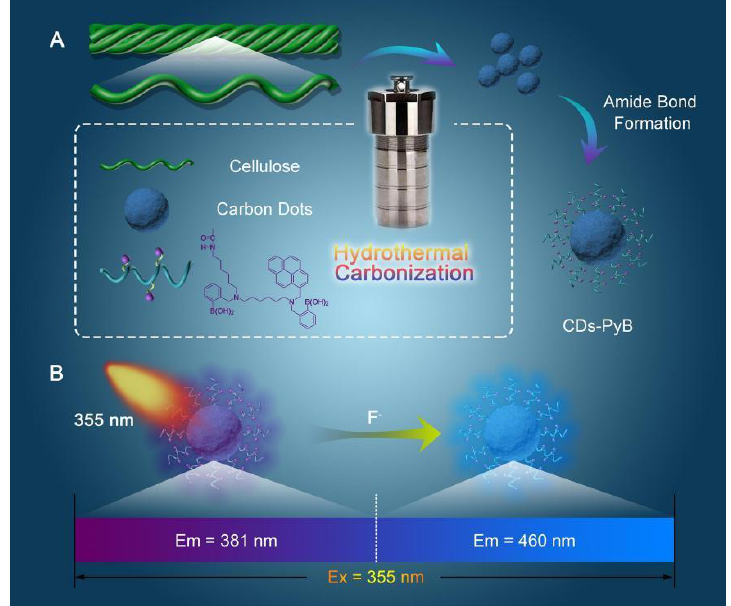
Figure 3. Schematic illustration of the synthetic process of CDs-PyB and the procedure of CDs-PyB. for fluoride ions detection. Adapted with permission from Li et al., 2020, copyright 2020. Reproduced with permission from Elsevier [39]